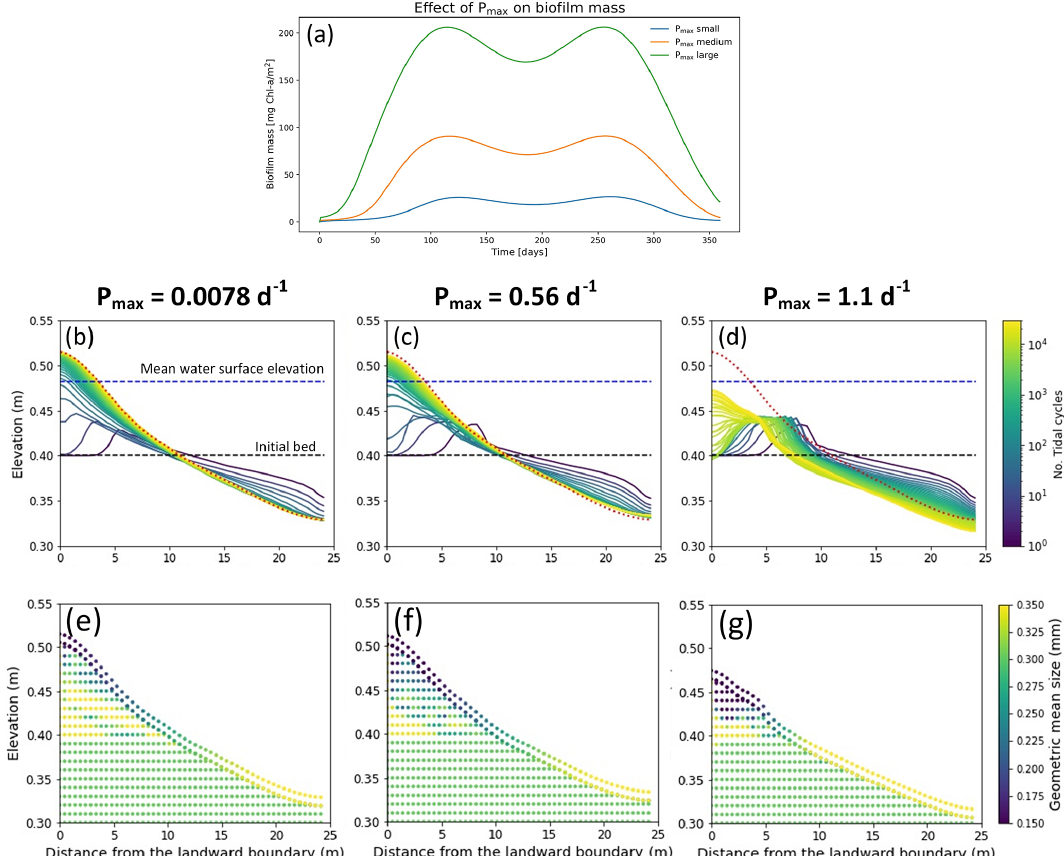
Figure 6. Effect of different values of maximum growth rate ( P max ) on the surface biofilm biomass (a) . The top row represents the bed evolution profile with small (b) , medium (c) and large (d) P max after 30000 simulated tidal cycles. The bottom row represents the geometric mean diameter of the final deposit in the case of small (e) , medium (f) and large (g) P max . The bed profiles are compared with the final bed elevation of clean sediment at equilibrium (dashed red lines). The dashed blue and green lines represent the initial water surface elevation and the initial bed profile, respectively. The initial geometric mean size of the bed is